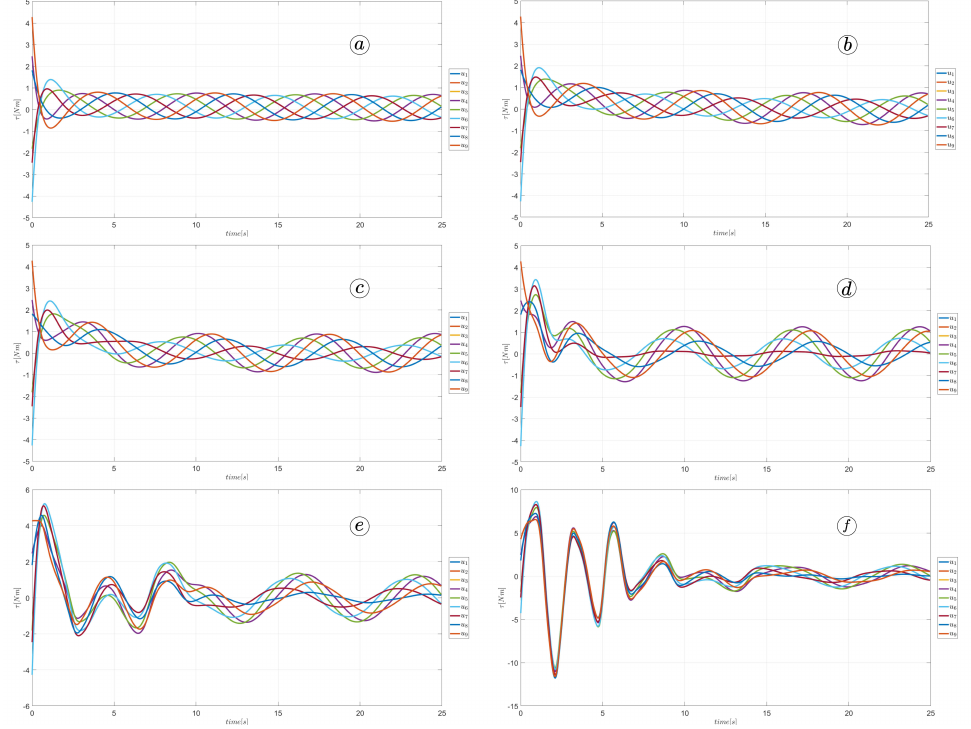
Figure 42. Torque in robot’s joints for k θ = 0.1 ( a ), k θ = 0.3 ( b ), k θ = 0.5 ( c ), k θ = 1 ( d ), k θ = 2 ( e ), and k θ = 3 ( f